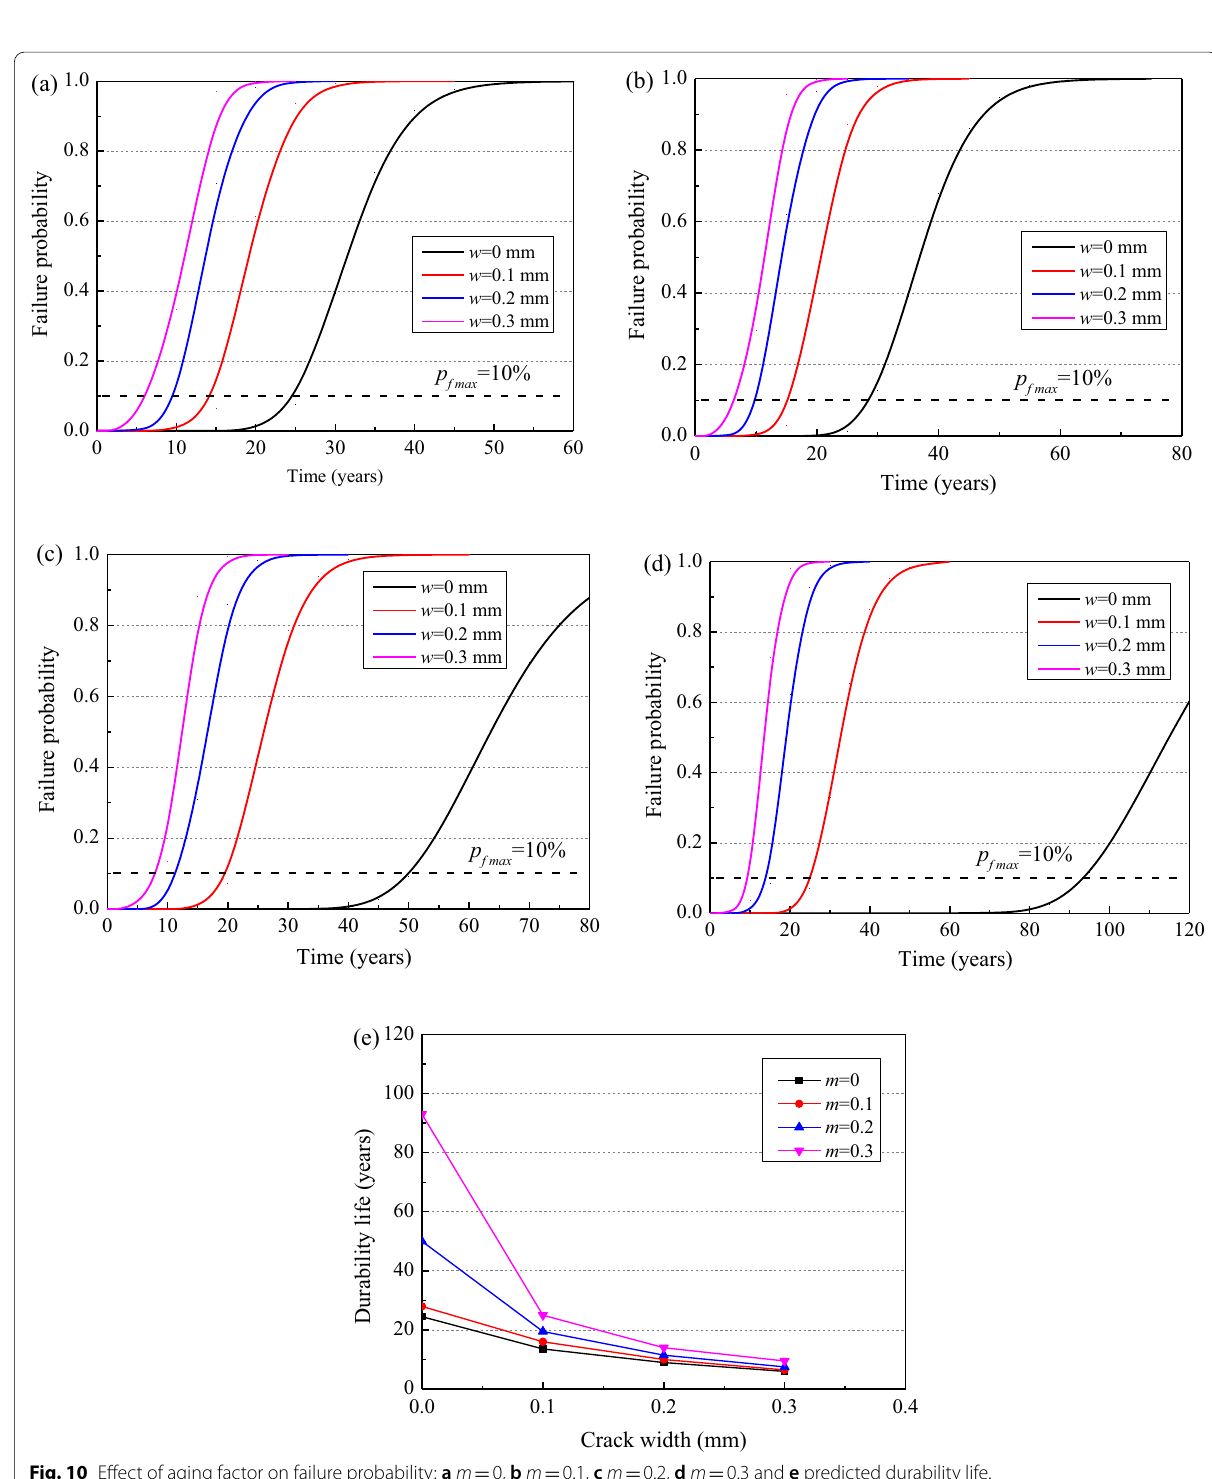
Fig. 10 Effect of aging factor on failure probability: a m